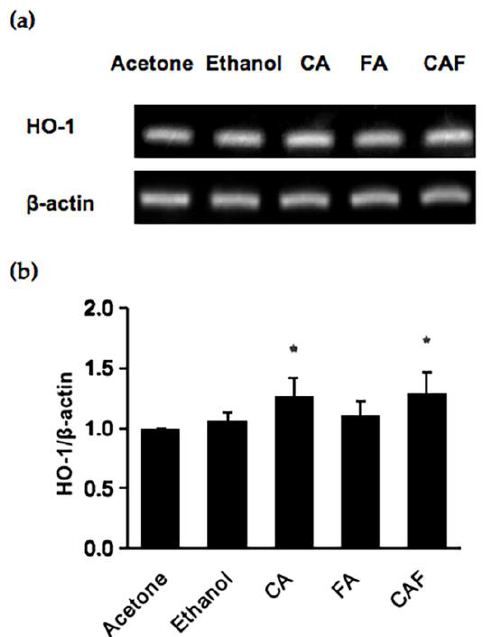
Figure 5. Comparison of the effects of cycloartenol (CA), ferulic acid (FA) and CAF on the HO-1 gene expression ( a , b ). Hepa1c1c7 cells were treated with 50 μM of CAF, CA, or FA for 6 h, and the mRNA level of HO-1 was analyzed by RT-PCR. Acetone was the vehicle for CAF and ethanol for CA and FA. All values were expressed as means ± SD of five separate experiments. * p < 0.05 vs. control.